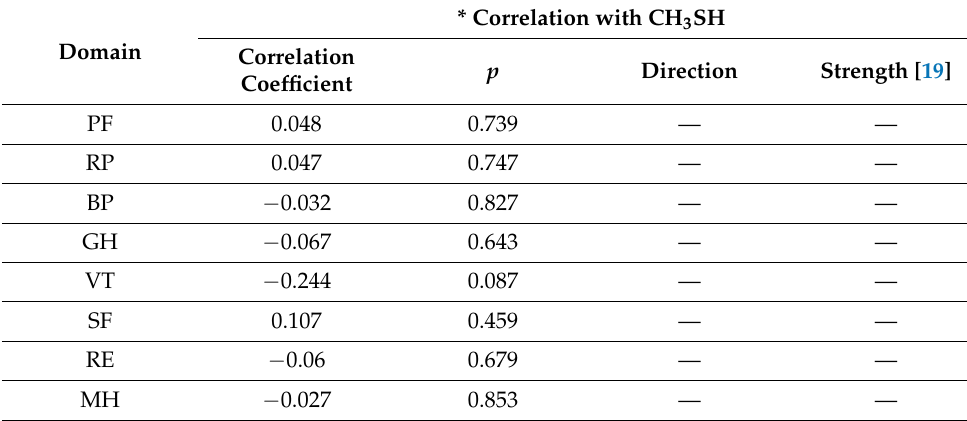
Table 4. SF-36 domains’ and CH 3 SH